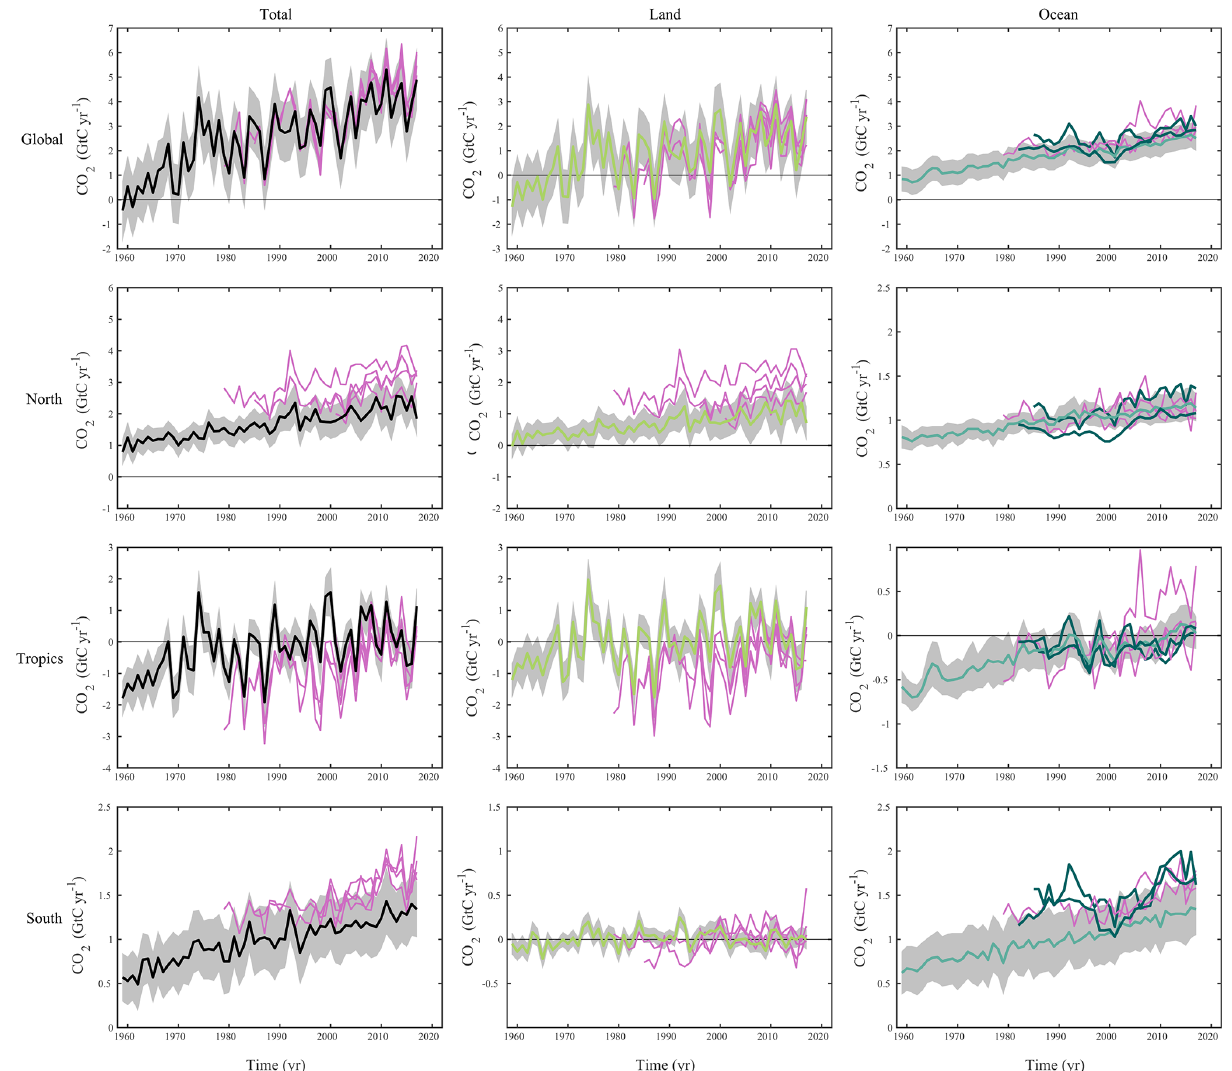
Figure 8. CO 2 fluxes between the atmosphere and the surface ( S OCEAN + S LAND − E LUC ) by latitude bands for the (top) globe (second row), north (north of 30 ◦ N), (third row) tropics (30 ◦ S–30 ◦ N), and (bottom) south (south of 30 ◦ S) and (left) total, (middle) land only ( S LAND − E LUC ), and (right) ocean only. Positive values indicate a flux from the atmosphere to the land and/or ocean. Estimates from the combination of the process models for the land and oceans are shown (black for the total, green for the land, blue for the ocean) with ± 1 σ of the model ensemble (in grey). Results from the atmospheric inversions (pink lines) and from the p CO 2 -based flux products (dark blue lines) are also